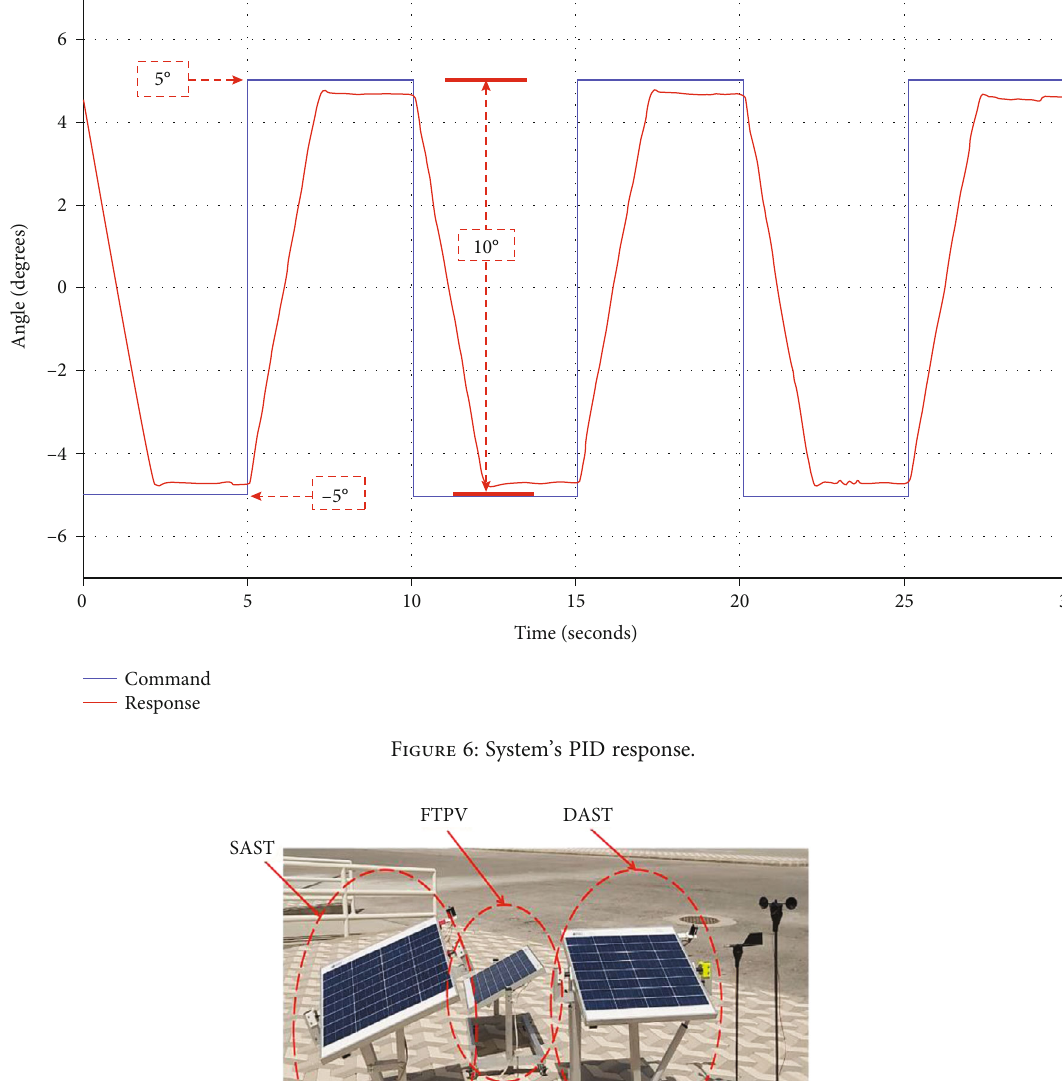
Figure 7: Experimental setup for FTPV, SAST, and